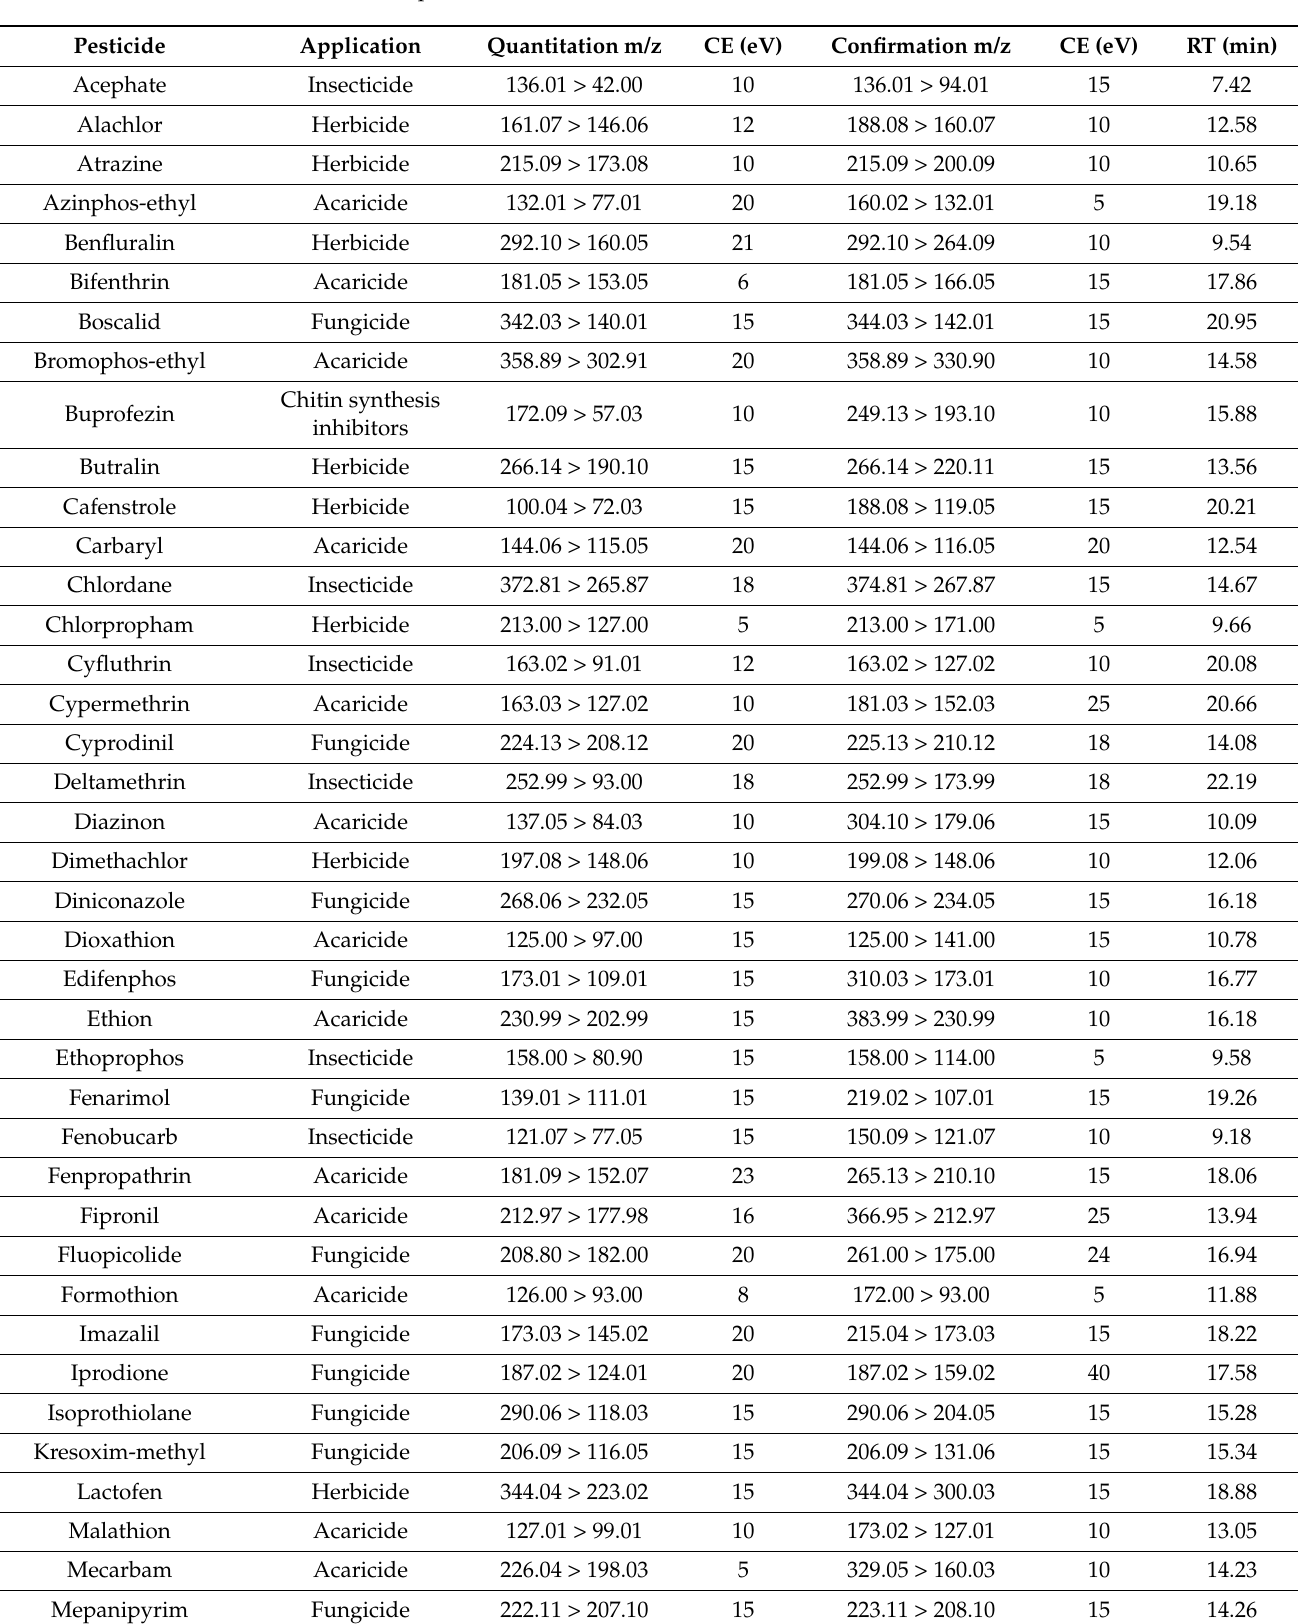
Table 5. GC-MS/MS retention times and multi reaction monitoring SRM transitions for the LC amenable